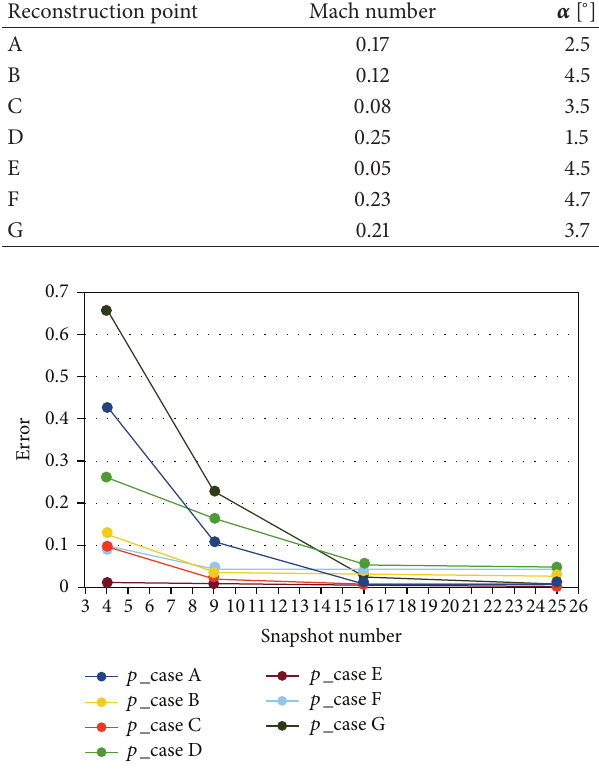
Figure 13: NACA 0012 airfoil. Errors generated by the PODI surrogate model for the reconstruction of the pressure field.